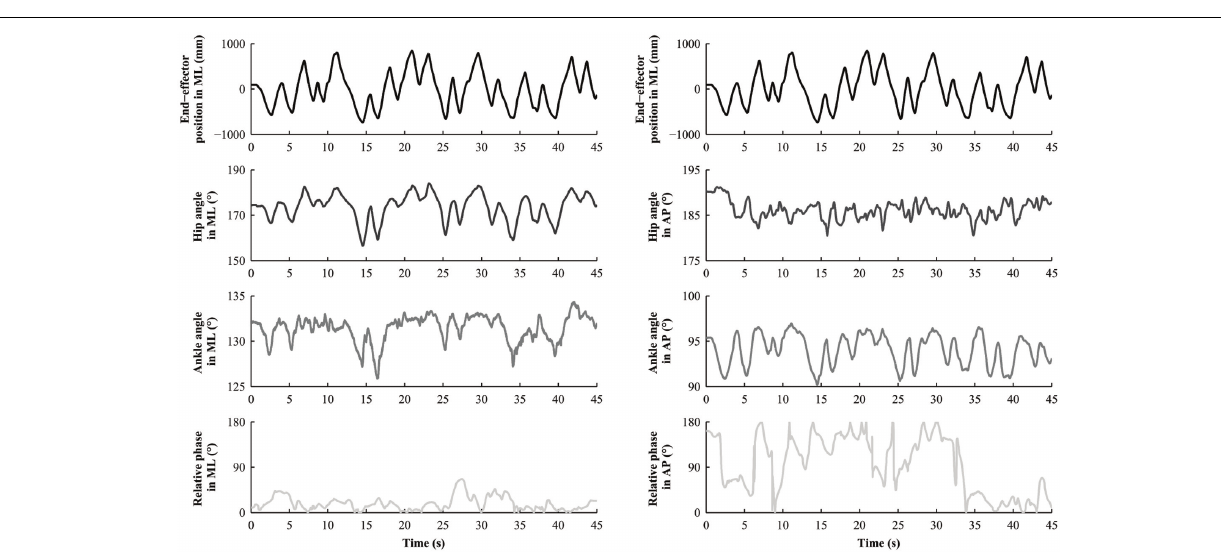
FIGURE 3 | Representative temporal series obtained in the Duo situation for one subject (Leader